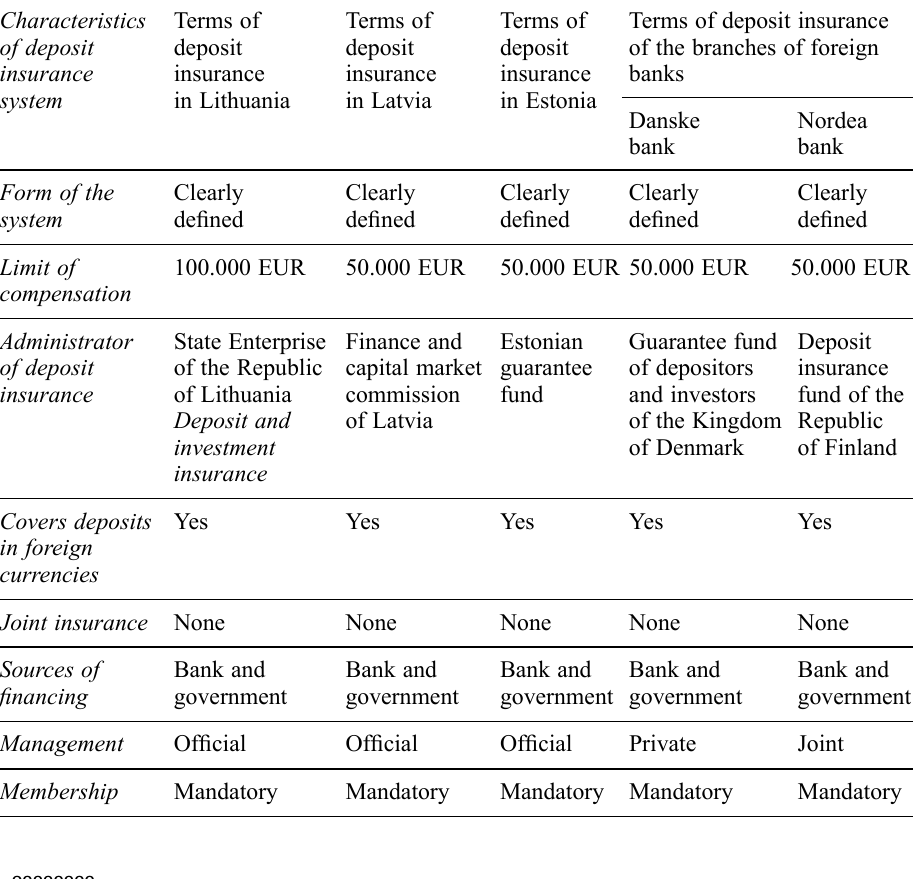
Table 5. Comparison of terms of deposit insurance of Baltic States banks and foreign country bank branches Characteristics